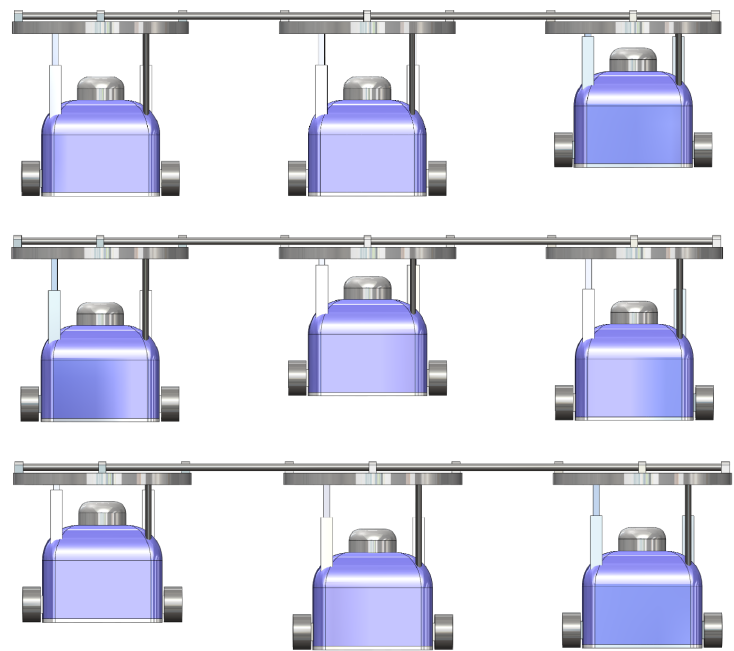
Figure 4. Transitioning steps during crossing the window frame.